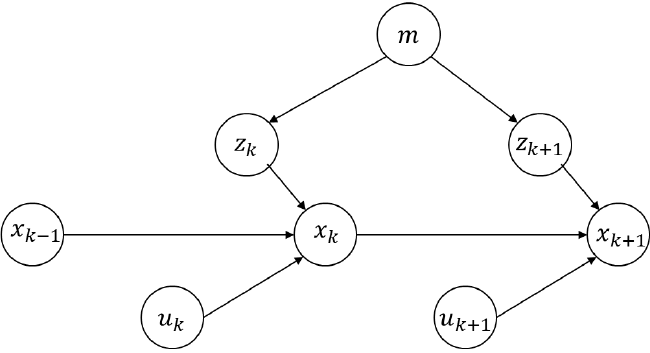
Figure 7. Mathematical representation diagram of the underground localization. x k − x k , and x k + 1 are represented as the posture of underground mining equipment at k − 1, k , and k + 1 time. u k represents the pose transformation between k − 1 and k . u k + 1 represents the pose transformation between k and k + 1. This value can be calculated by the point cloud registration method at two moments. m represents the point cloud map. z k and z k + 1 represent the observation values at k and k + 1 time, which is the return point cloud information of 3D LIDAR.